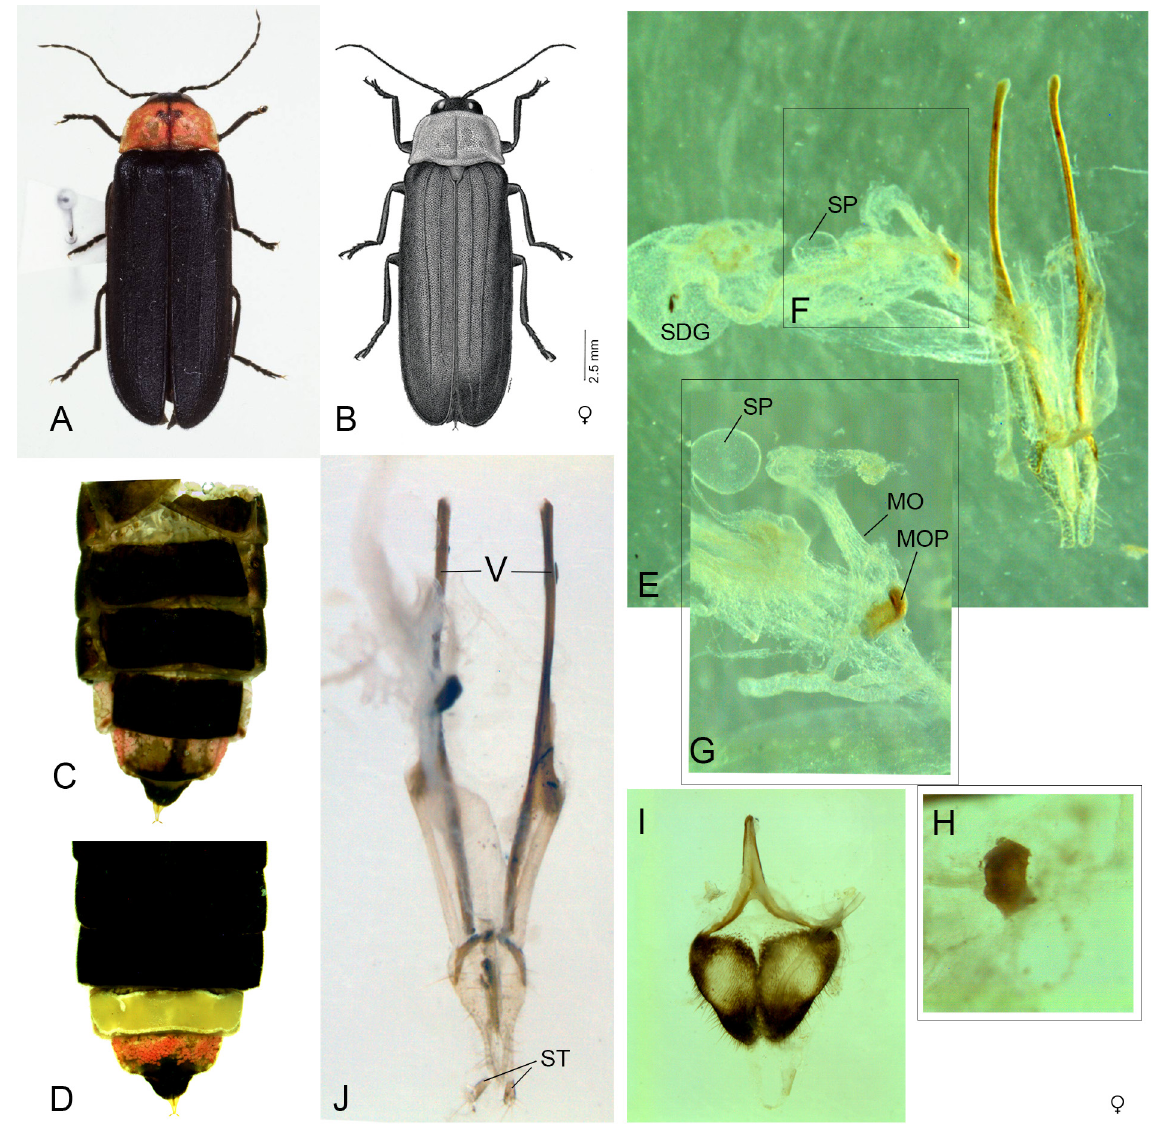
Fig. 7. Female morphology. A, C-J . Nipponoluciola cruciata (Motschulsky, 1854) gen. et comb. nov. ♀ (Doubaru, Japan; ANIC). B . Nipponoluciola owadai (Satô & Kimura, 1994) gen. et comb. nov. A–B . Habitus, dorsal view. C–D . Abdomen, dorsal (C) and ventral (D) view. E–G . Female reproductive tract. E . With ovipositor to right and SDG to left. F . Area of bursa. G . Spermatheca to left. H . MO plate posterior end to right. I . V8 ventral surface. J . Ovipositor. Abbreviations: MO = median oviduct; MOP = median oviduct plate; SDG = spermatophore digesting gland; SP = spermatheca; ST = styli; V = valvifers. Images by I. Kawashima (A–B) and by L. Ballantyne